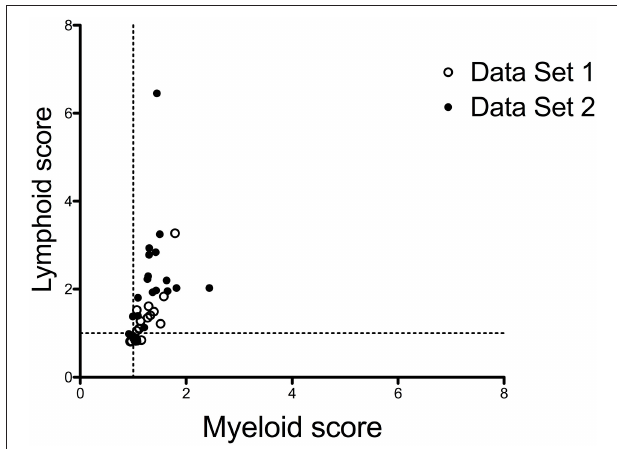
FIGURE 1 | Correlations between myeloid and lymphoid scores in RA synovitis. Lymphoid and myeloid gene scores were calculated in 2 sets of 20 biopsies from patients with active RA, based on gene lists used by Dennis et al. ( 16), downloaded from https://arthritisresearch.biomedcentral.com/ articles/10.1186/ar4555#MOESM3. Gene scores are the median values of the log2- transformed fold changes of each transcript belonging to the score compared to a reference group of 4 OA samples. Data set 1: synovial samples from RA patients with early disease, published in Ducreux et al. (23). Data Set 2: unpublished set of synovial samples, from RA patients with established disease. The characteristics of the patients in both data sets are displayed in Supplementary Table 1 . Spearman correlation coefficient r =